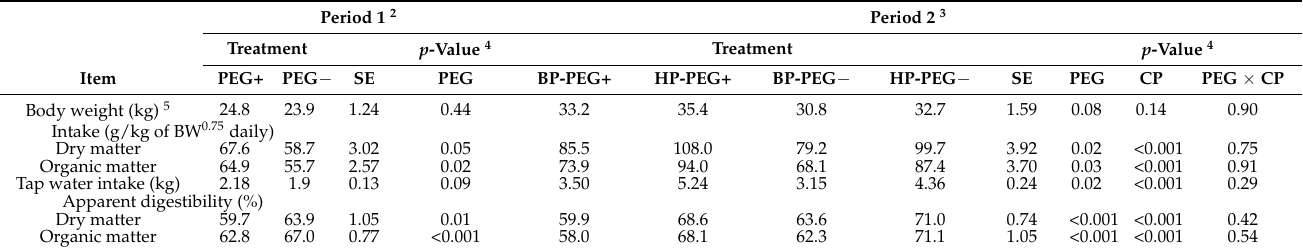
Table 2. Effect of experimental diets on the intake, digestibility, and BW in lambs in experimental periods 1 and 2 1 .